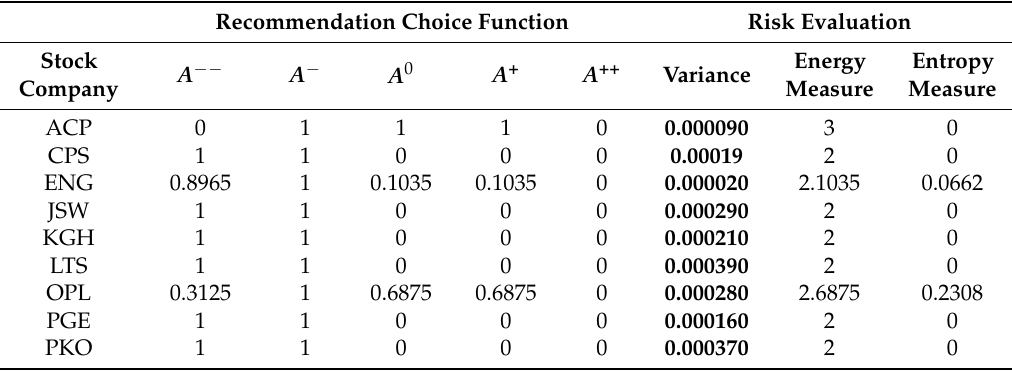
Table 3. Imprecise